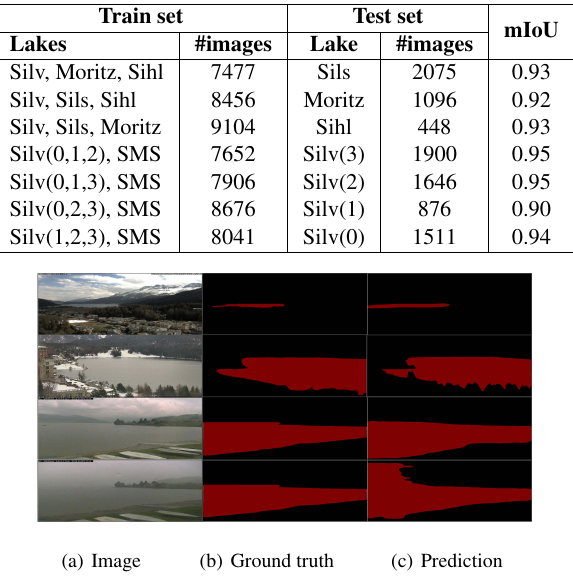
Figure 7: Results of lake detection using Deeplab v3+ . The first three rows shows successful cases, a failure case is displayed in the last row.